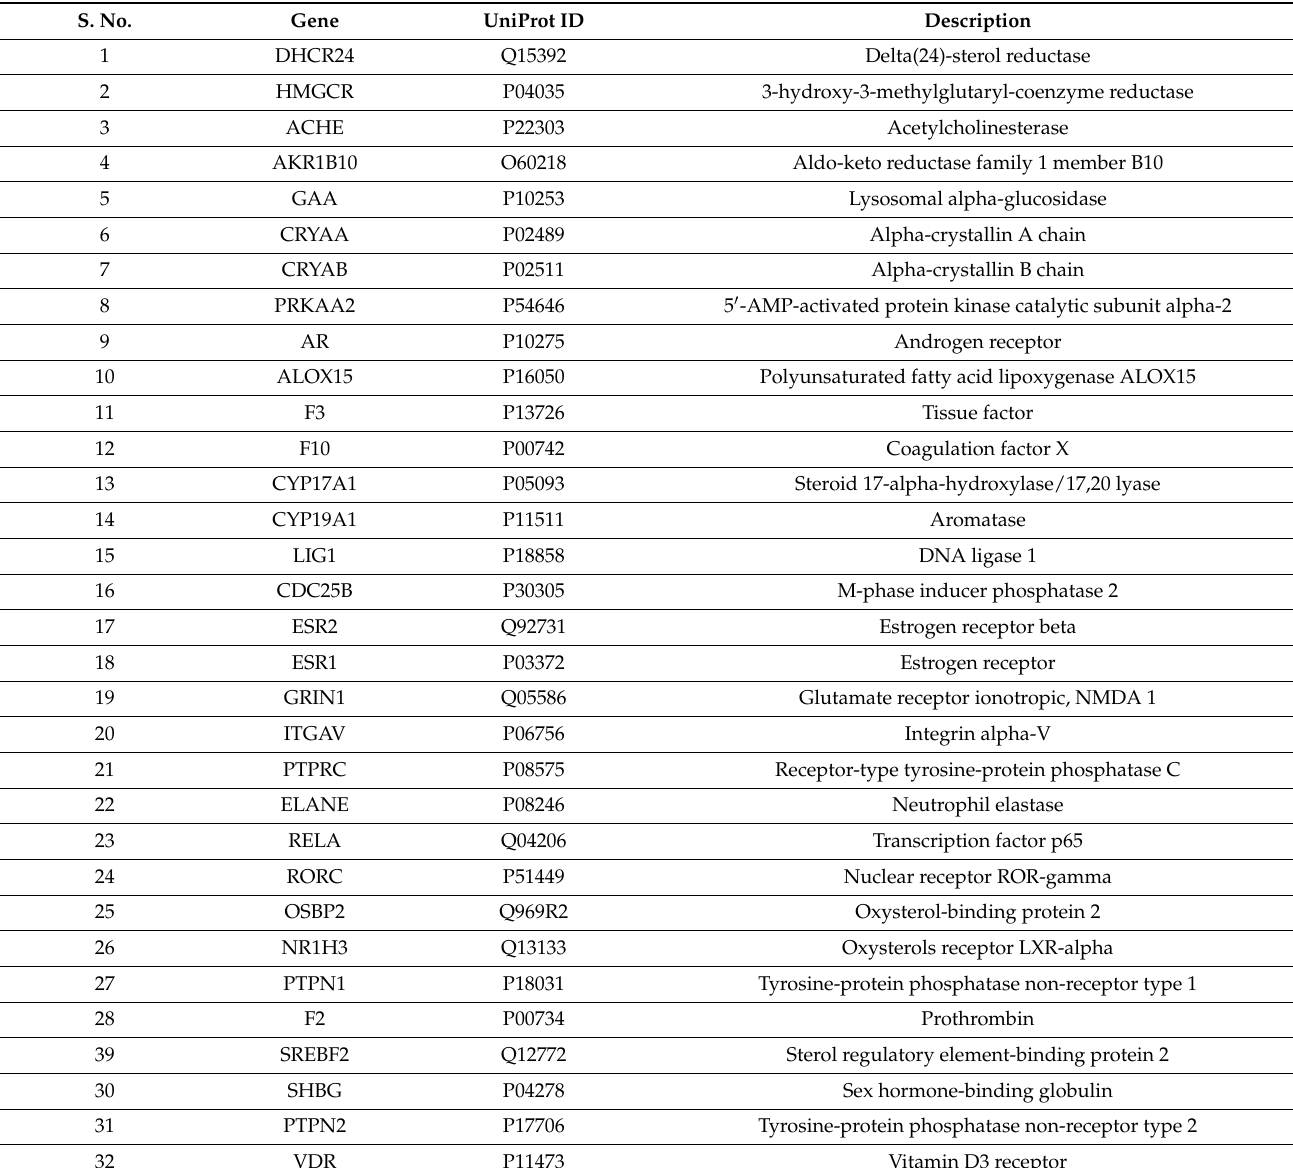
Table 2. Potential genes targeted by